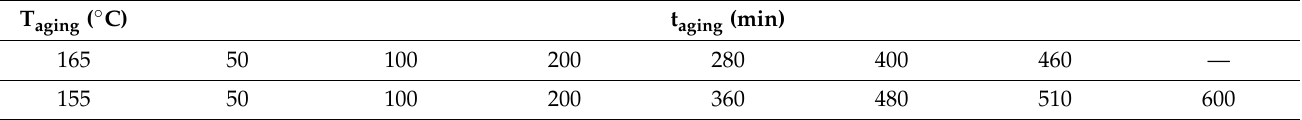
Table 3. Parameters used during the aging step (TA